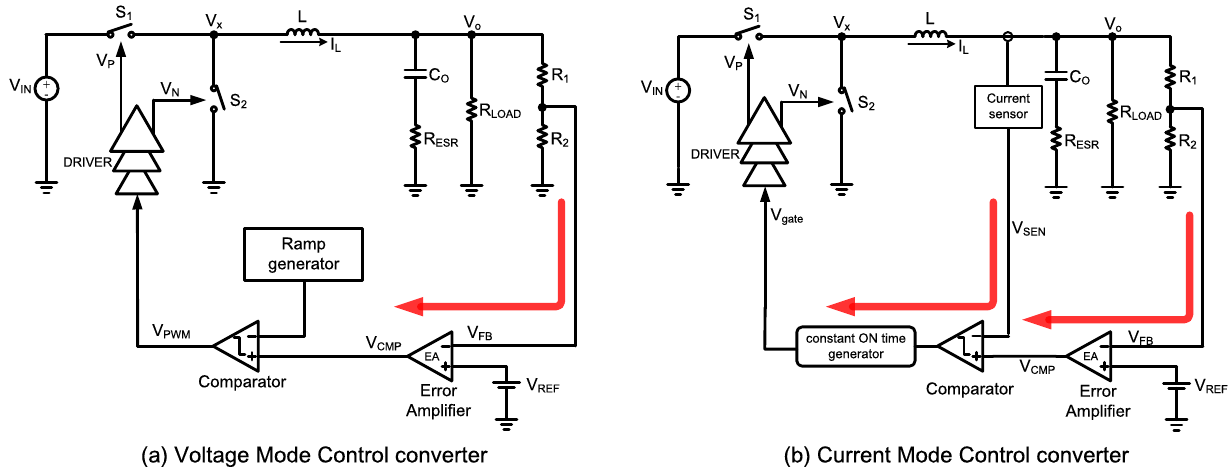
Figure 1. The control topology of the conventional converter.